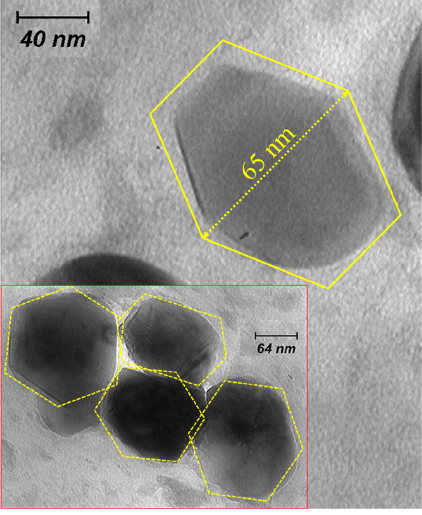
Figure 8. TEM image of calcium/titania-zirconia catalyst synthesised via sol-gel method at the optimum conditions suggested by GA.